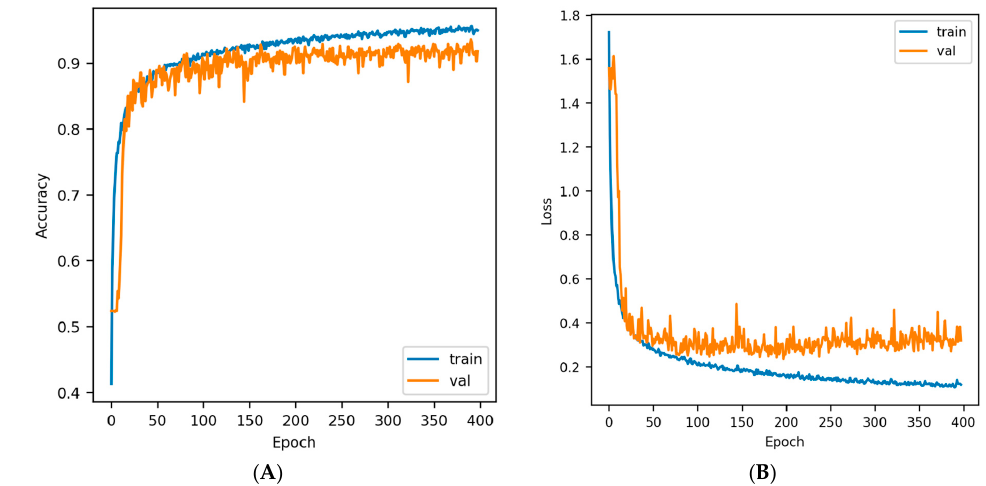
Figure 10. Bi-LSTM RNN training curves ( A ) Accuracy vs. Epoch; ( B ) Loss vs. Epoch.